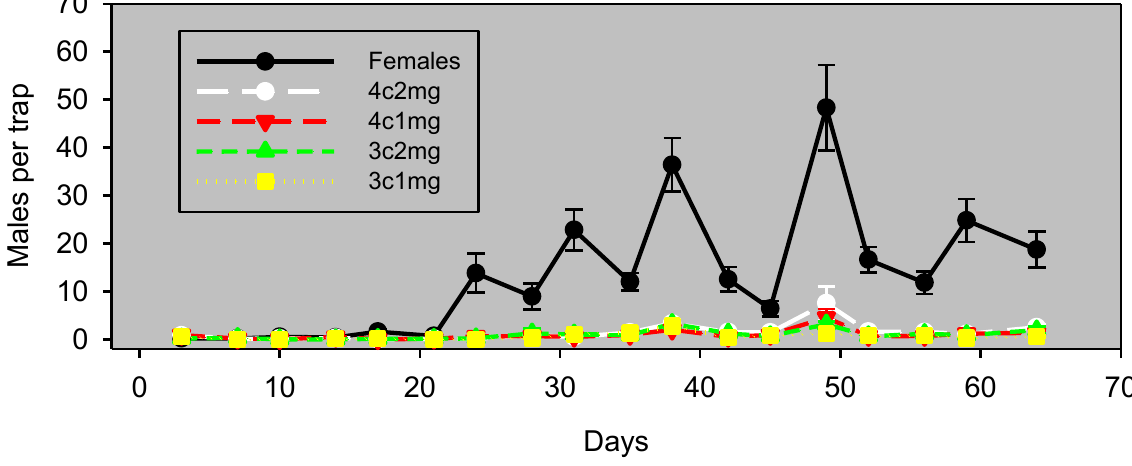
Figure 5 . Experiment 3: males captured (mean ± SE) in pistachios, by monitoring the interval in wing traps baited with unmated females or artificial lures, starting April 29, 2012. Blocks were 120 m apart, and traps within blocks were 60 m apart. The lure preparation is as in Table